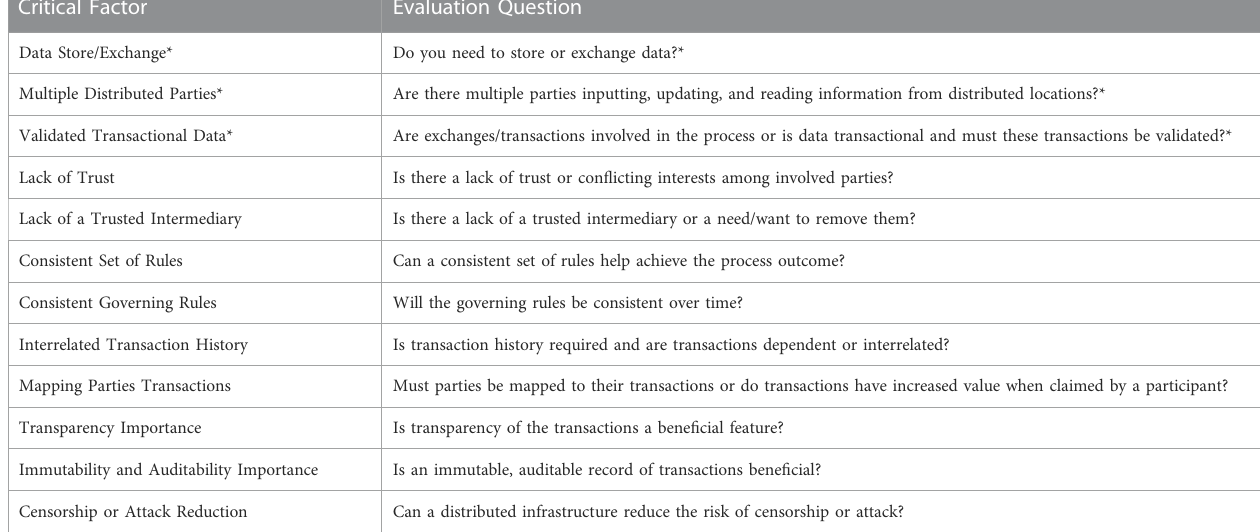
TABLE 2 Critical Factor Evaluation